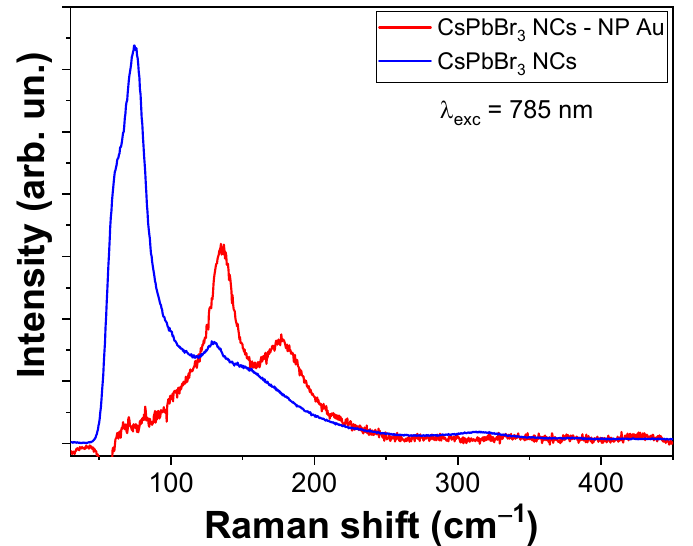
Figure 6. Raman spectrum of NP Au soaked with CsPbBr 3 NCs (red) compared with pure CsPbBr 3 NCs (blue).